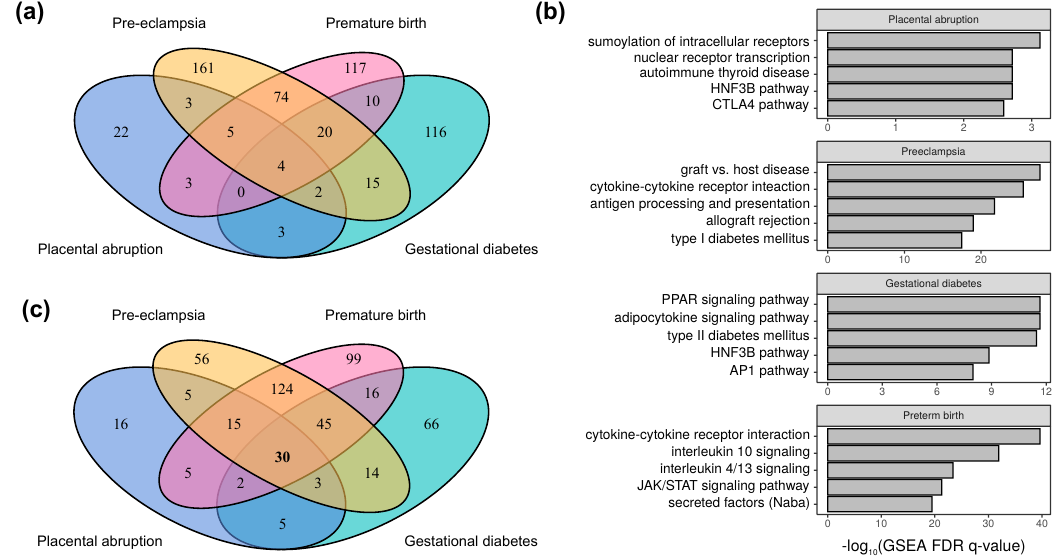
Figure 2. HuGE Navigator-based analysis of the genes involved in pathogenesis of pregnancy-related traits and diseases. ( a ) Venn diagram representing the number of candidate genes shared by the four major traits included in the analysis. ( b ) Top-5 enriched molecular pathways for each of the traits identified using clusterProfiler [21] analysis with MSigDB canonical pathways. ( c ) Venn diagram representing the overlap between top-100 enriched gene sets for each pathology. Note that on ( a , c ), preeclampsia and premature birth share the largest number of individual genes and enriched